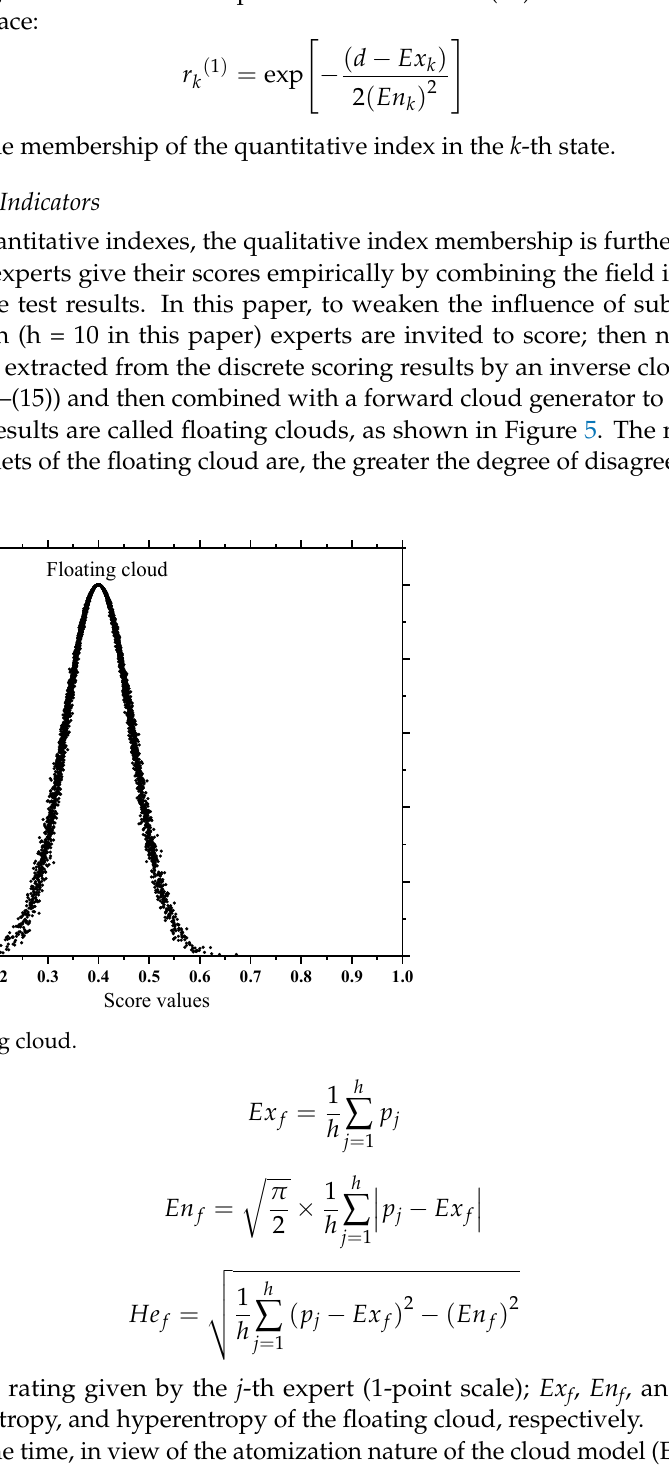
Figure 4. Degradation calculation of different types of indicators.